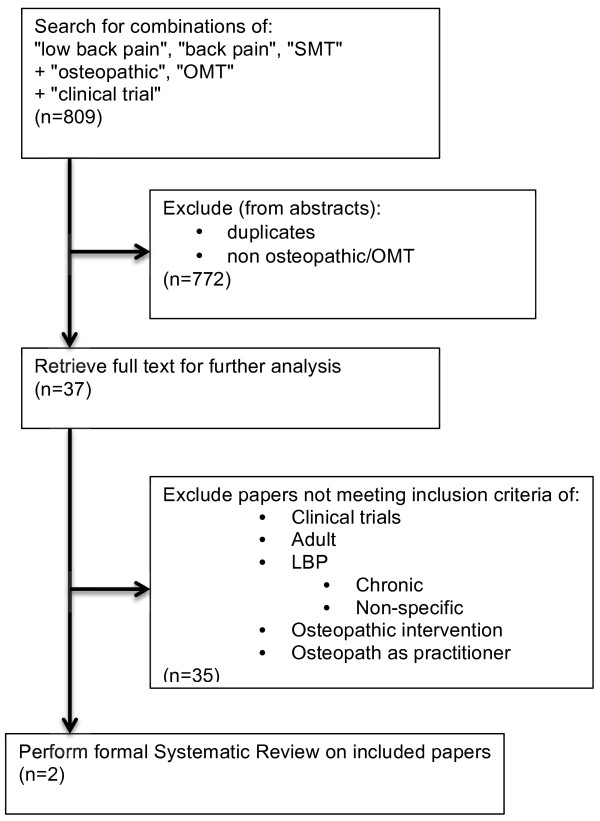
Flowchart of paper selection.